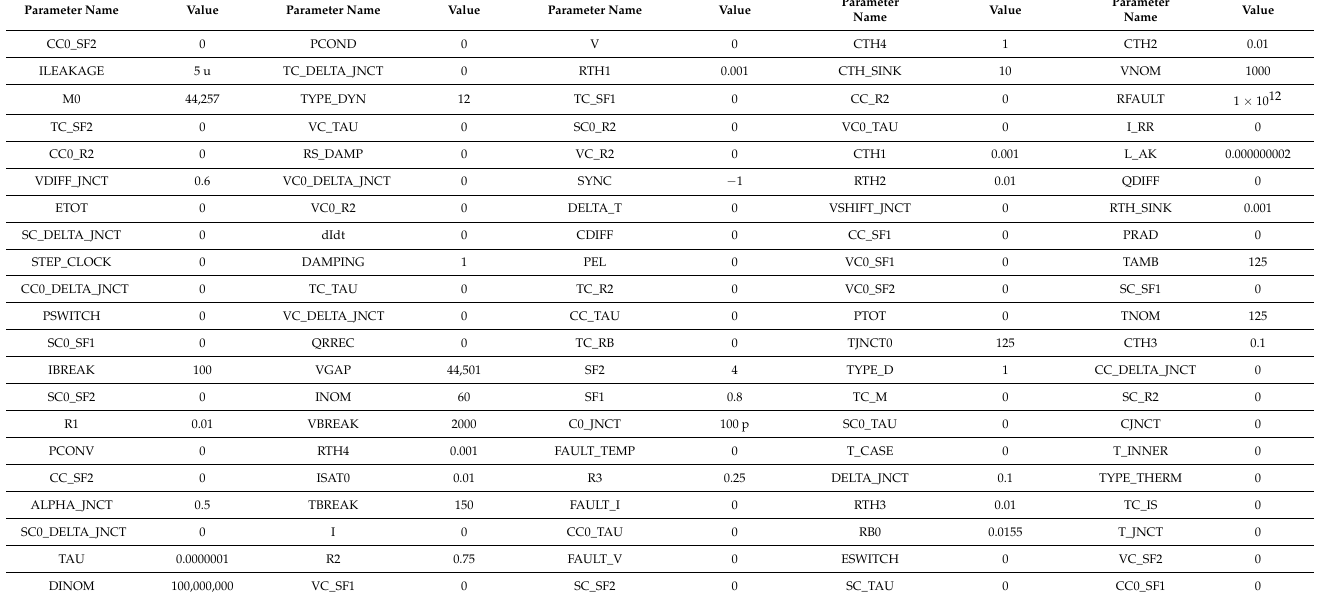
Table A2. Electrical parameters of the diodes D1–D4 from Figure